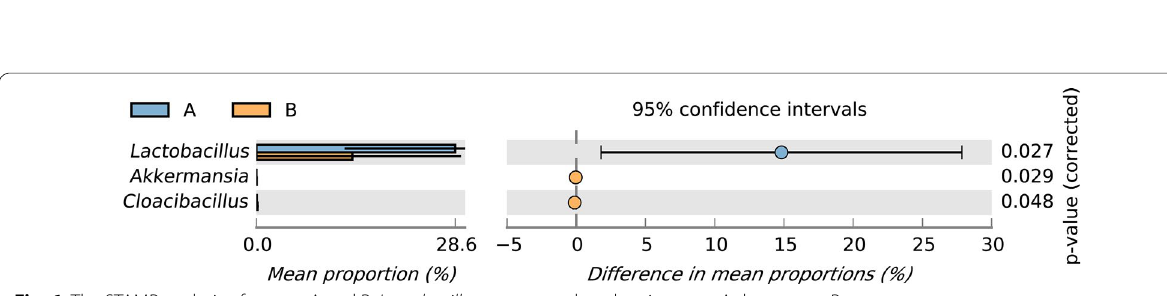
Fig. 6 The STAMP analysis of groups A and B. Lactobacillus was more abundant in group A than group